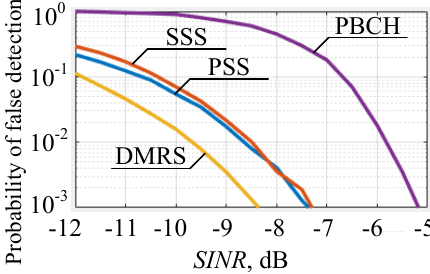
Fig. 3. False detection probability of SBB